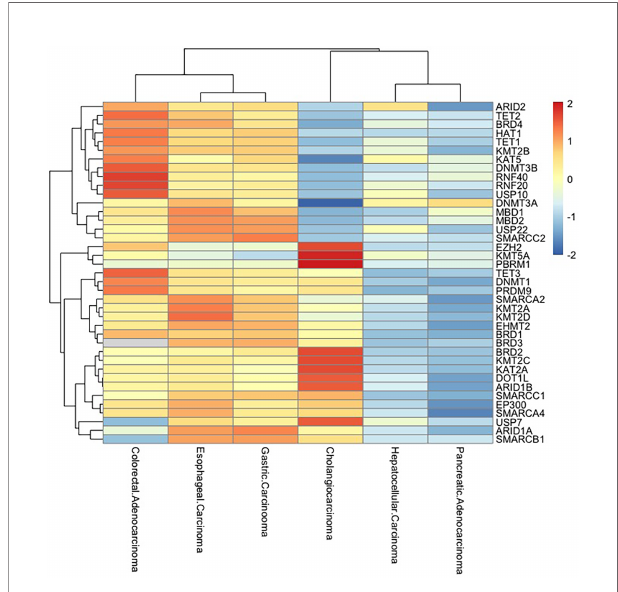
as a heatmap. The mutation rates of these genes are high in esophageal carcinoma, gastric carcinoma, and colorectal adenocarcinoma, while pancreatic adenocarcinoma and hepatocellular carcinoma have low mutation